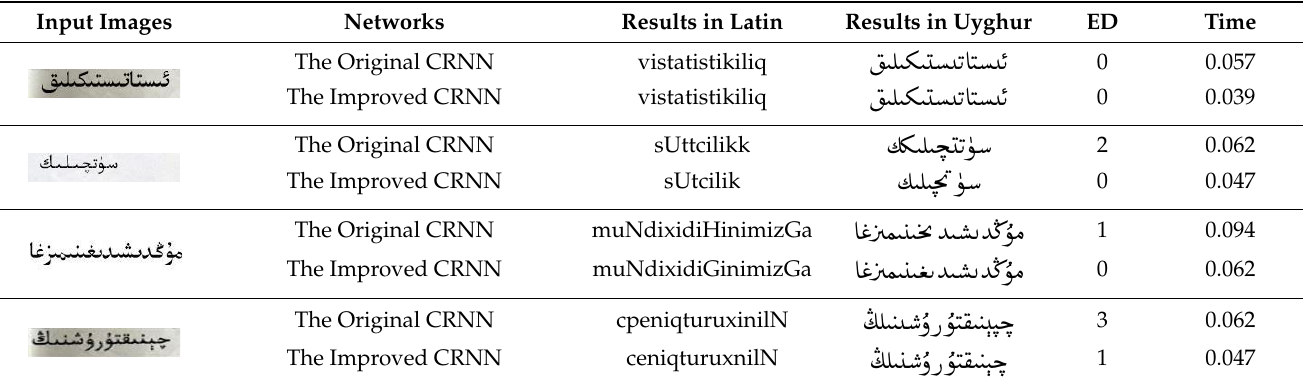
Table 4. Experimental results at 640 × 640 scale on the Total-Text dataset, Pre-Train represents whether to use the pre-training dataset for fine-tuning. “Y” means using pre-training, “N” means not using pre-training. “P”, “R” and “F” stand for “precision”, “recall” and “F-measure” respectively.